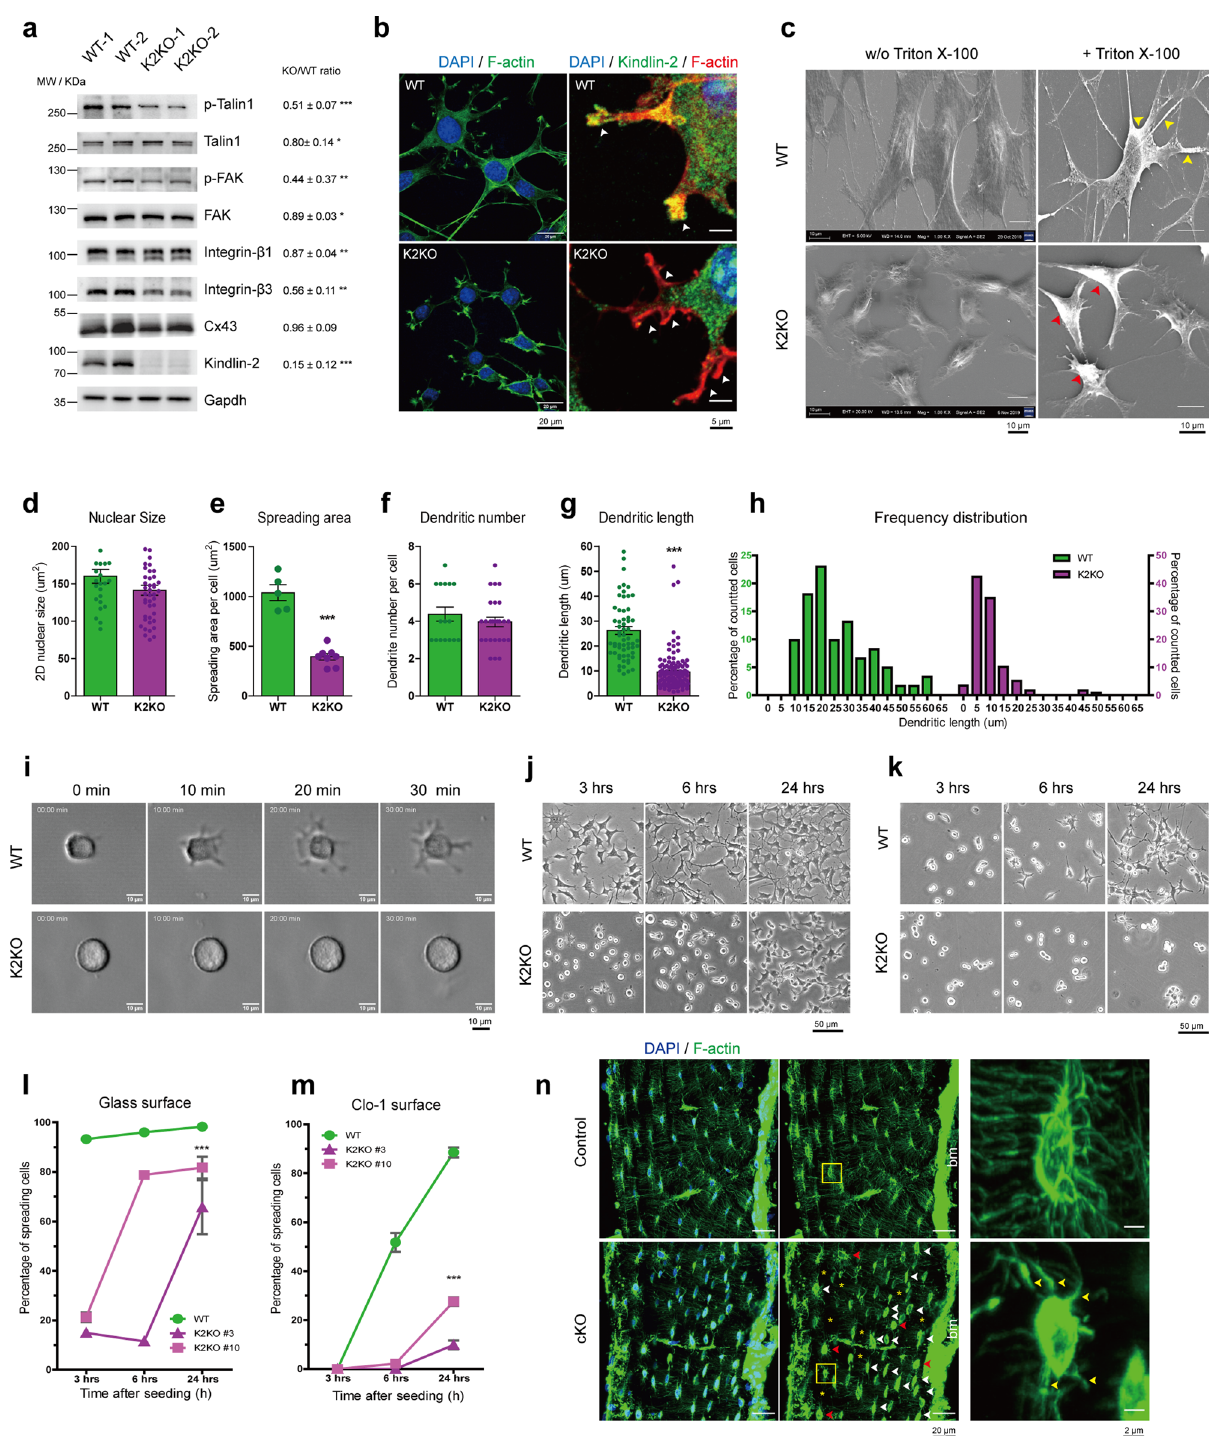
Fig. 4 MLO-Y4 cells with Kindlin-2 deletion exhibit dramatic focal adhesion defects and cytoskeleton alternation. a Western blot results for wild-type (WT) and Kindlin-2 knockout (K2KO) MLO-Y4 cells. b Immuno fl uorescence (IF) staining for DAPI, F-actin, and Kindlin-2 in WT and K2KO cells. c Scanning electron microscopy (SEM) images for the cytoskeleton of WT and K2KO cells with and without TX-100 treatment. d – h Quantitative analysis for nuclear area, spreading area, dendritic number, dendritic length, and the frequency distribution of dendritic length of WT and K2KO MLO-Y4 cells. i Representative images from live tracking of single cell spreading within the fi rst 30 minutes after seeding of WT and K2KO MLO-Y4 cells on uncoated glass bottom dishes. Representative images of WT and K2KO spreading and attachment on non-coated glass surface ( j ) and Col-1 coated surface ( k ) at 3, 6, and 24 h after seeding. Statistical analysis of percentage of spreading cells for WT and K2KO cells on glass surface ( l ) and Col-1 coated surface ( m ) at 3, 6 and 24 h after seeding. n Rhodamine-Phalloidin staining for F-actin over 20 μ m tibia bone sections from Control and cKO mice. Quantitative results from at least three independent experiments. * P < 0.05, ** P < 0.01, *** P < 0.001, versus controls, Student ’ s t test. Results are expressed as mean ± standard deviation